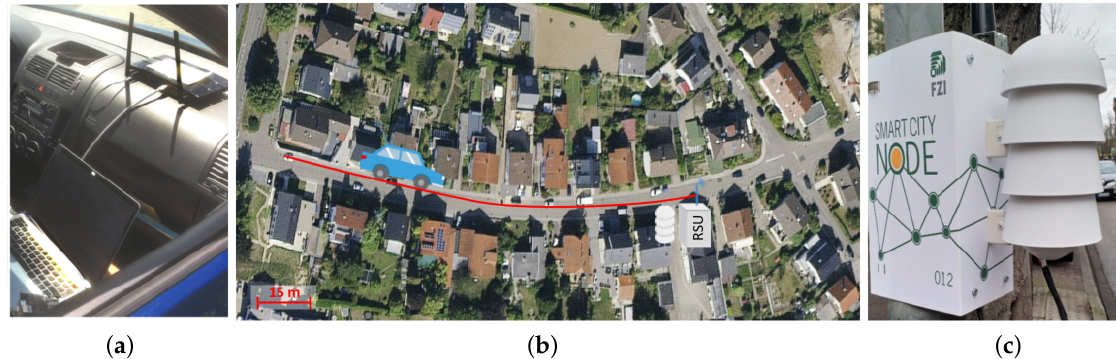
Figure 2. The scenario setup for the viability assessment including the car ( a ), the road driven with the car during the viability assessment ( b ), and the RSU mounted along the road ( c